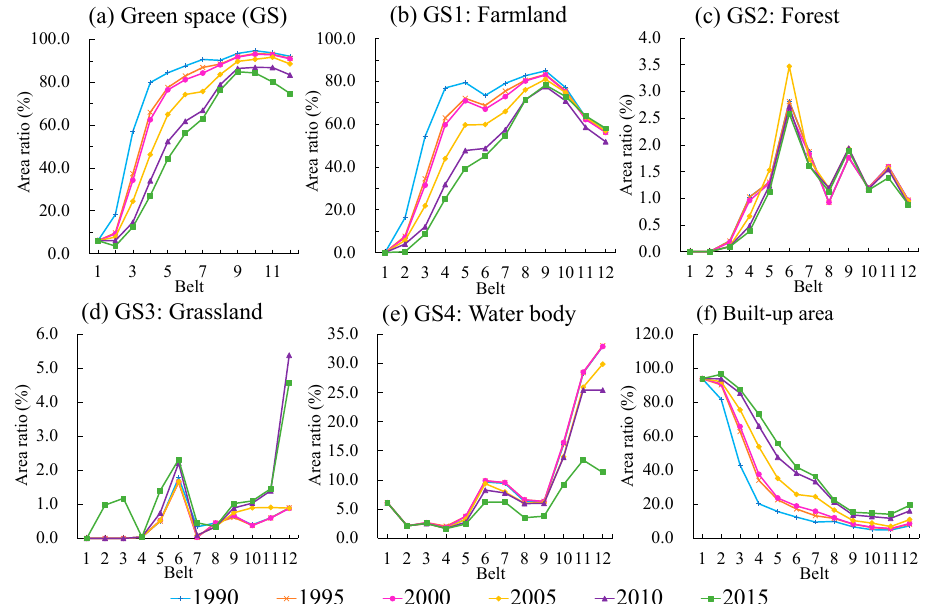
Figure 6. The spatiotemporal changes in the green space along the concentric buffers. ( a ) The changes in overall green space along the concentric buffers; ( b ) The changes in farmland along the concentric buffers; ( c ) The changes in forest along the concentric buffers; ( d ) The changes in grassland along the concentric buffers; ( e ) The changes in water body along the concentric buffers; ( f ) The changes in built-up area along the concentric buffers.